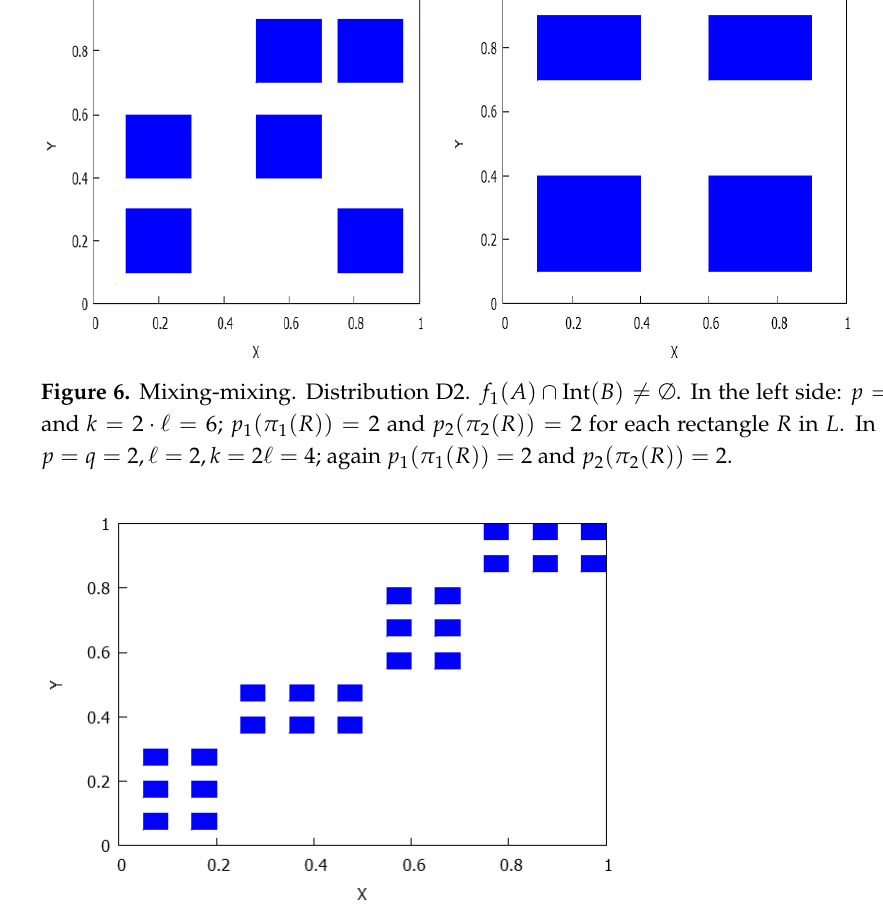
Figure 7. A and B mixing. Distribution D3. We define L 1 as the set of rectangles R such that p 1 ( π 1 ( R )) = 3 and p 2 ( π 2 ( R )) = 2. The contrary occurs for rectangles R (cid:48) in L 2 , for which p 1 ( R (cid:48) ) = 2 and p 2 ( R (cid:48) ) = 3. Thus, | L 1 | = | L 2 | = 12 and | L | = | L 1 ∪ L 2 | = 24; A contains 4 disjoint intervals, B is made of 6 disjoint intervals and f 1 ( A ) ∩ B = ∅ . Observe that (cid:96) = lcm ( 4,6 ) = 12.